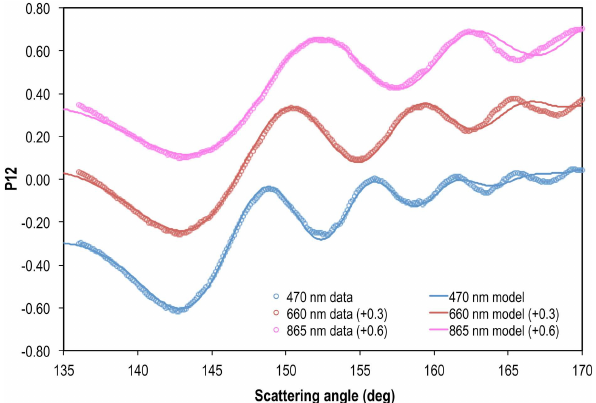
Fig. 19. Estimates of scattering phase matrix element P 12 derived from primary cloudbow and supernumerary bow data acquired by AirMSPI off the coast of Southern California on 31 August 2011 (open circles). Observations at the same scattering angle have been binned together in steps of 0.125 ◦ . Corrections for view and il- lumination geometry, Rayleigh transmittance and scattering, and ozone absorption have been applied to the data. The model results (solid lines) are derived following the methodology of Br´eon and Goloub (1998). The results shown are for a droplet size distribution with an effective radius of 7.5µm and effective variance of 0.01. The model takes into account the spectrally varying index of refrac- tion of water. To make the plots more visible, the data and model results at 660nm have been offset upwards by 0.3, and the results at 865nm have been offset upwards by